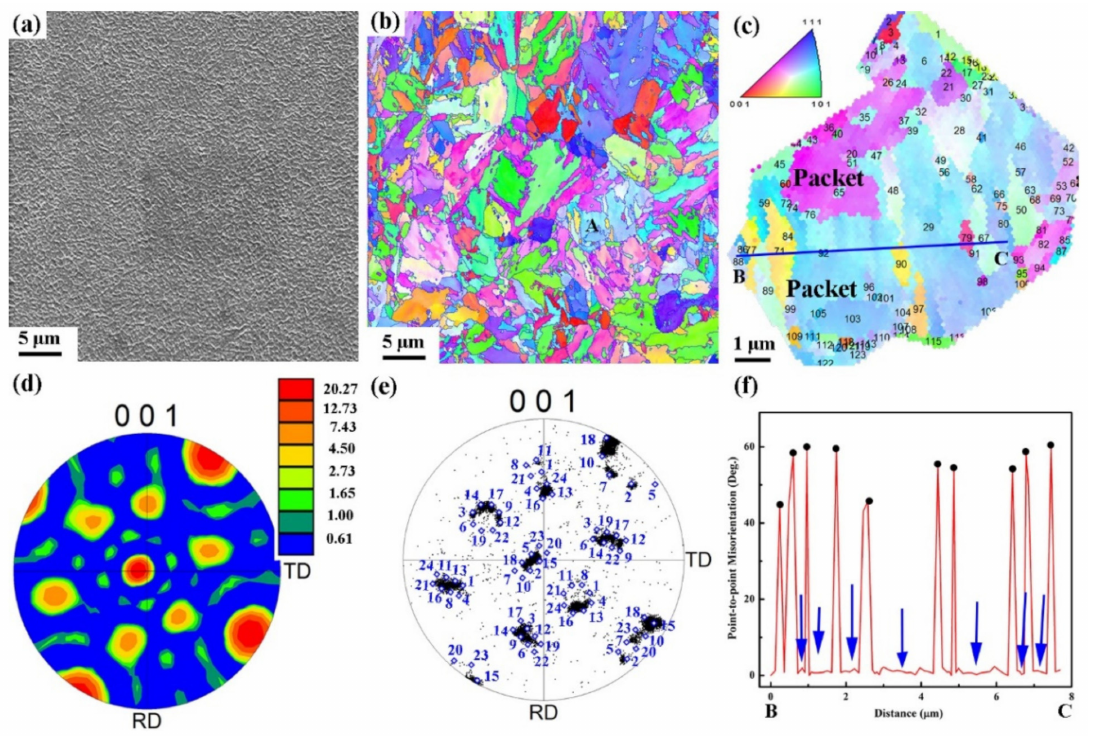
Figure 4. ( a ) SEM image of the as-built SLM-processed LH. ( b ) Corresponding inverse pole figure (IPF) figure of ( a ). ( c ) The cropped region A from ( b ). ( d ) The corresponding ODF figure of ( c ). ( e ) { 001 } pole figure shows the orientation of the martensite crystals within the prior austenite corresponds to ( c ). The symbols and numbers were corresponding to the variant numbers described in reference [23]. ( f ) Distribution of misorientation values along BC